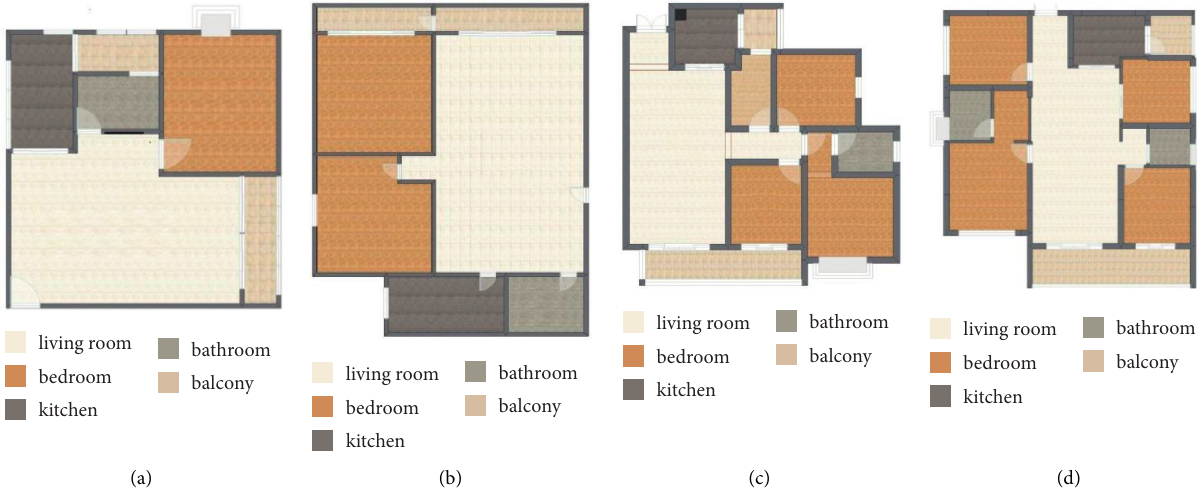
Figure 4: 2D floor plans for unfurnished indoor scenes: (a) single-bedroom set, (b) two-bedroom set, (c) three-bedroom set, and (d) four- bedroom